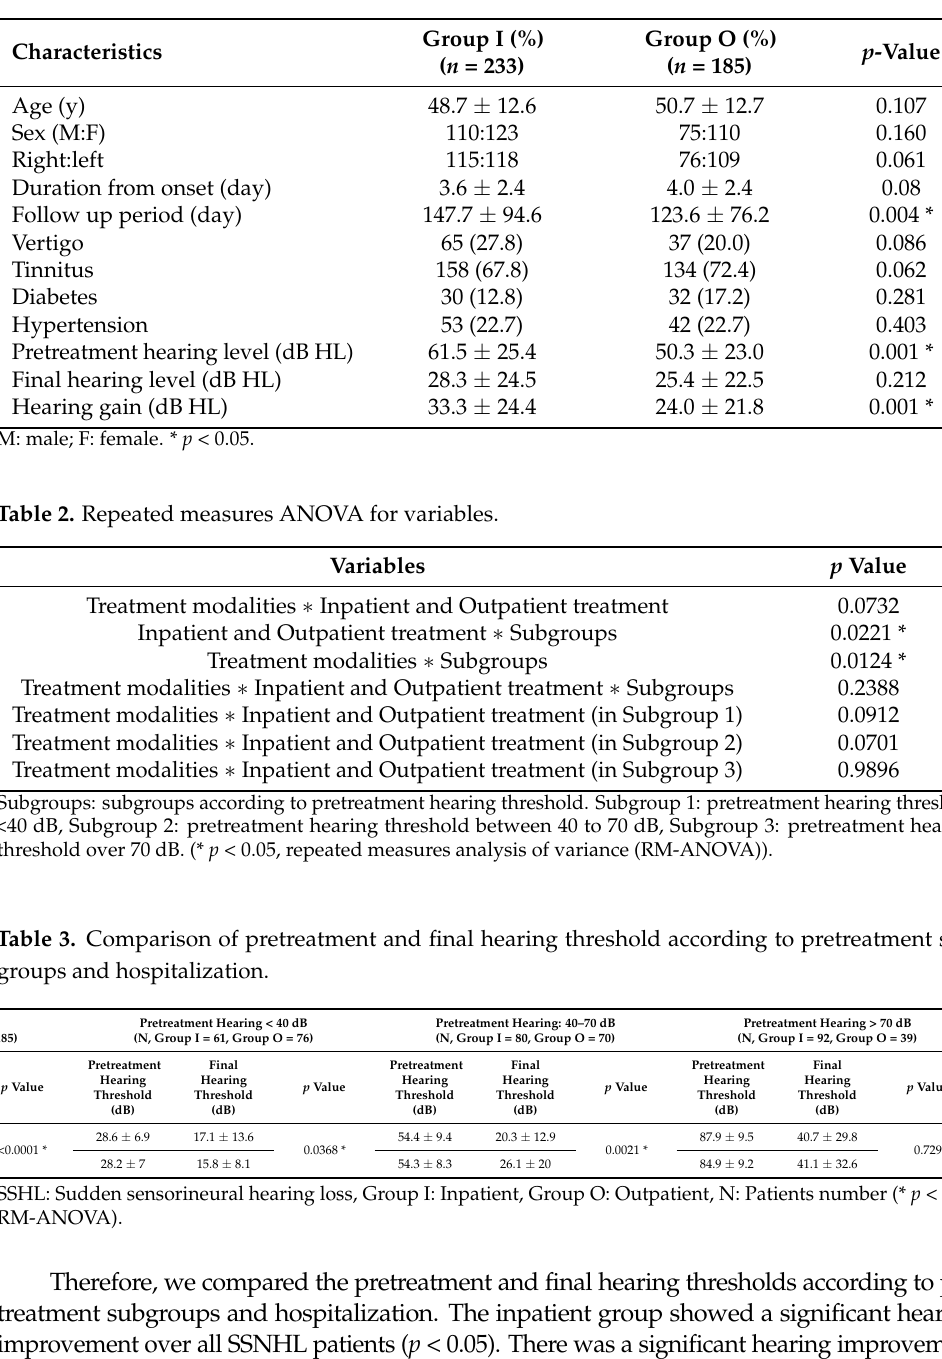
Table 1. Demographic data and treatment outcome of all patients.